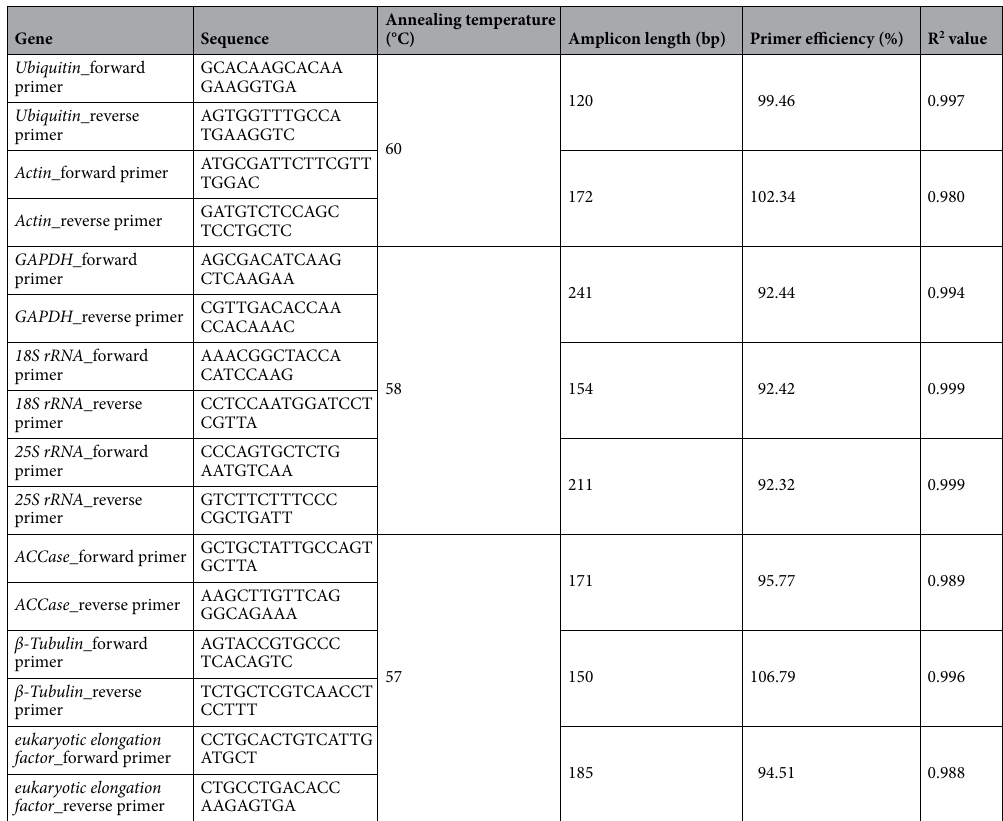
Table 1. Primer information of the eight candidate reference